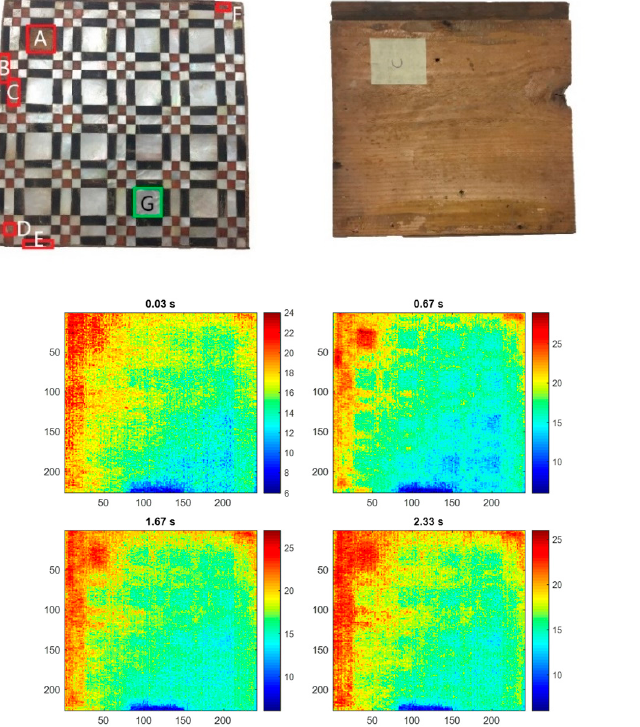
Figure 2. ( top ) ancient marquetry sample, ( middle ) back of the sample, and ( bottom ) raw thermal images collected at the 0.03, 0.67, 1.67, and 2.33 s during the heating and cooling process.